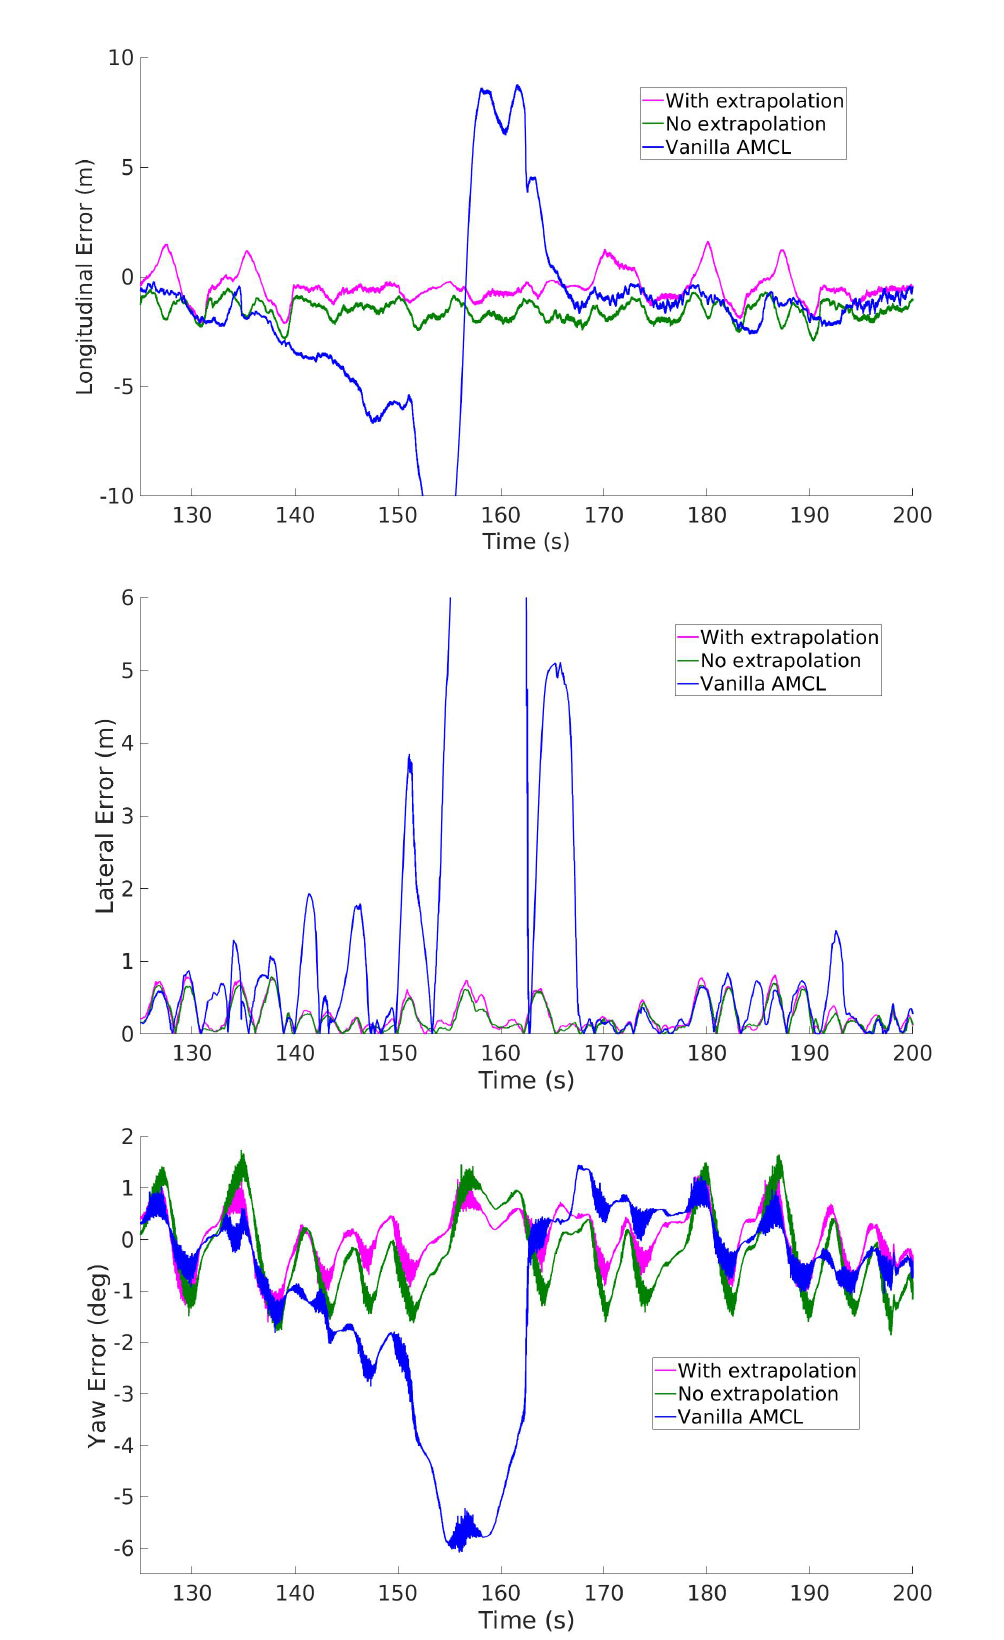
Figure 13. Comparison of the longitudinal, lateral and heading errors of two variants of IAMCL (with and without the extrapolation defined in Equation (7)) and AMCL during the third lap of the dataset, with focus on an AMCL failure (due to robot kidnapping). Note that IAMCL does not suffer from such situation even if they share the same underlying scan matching